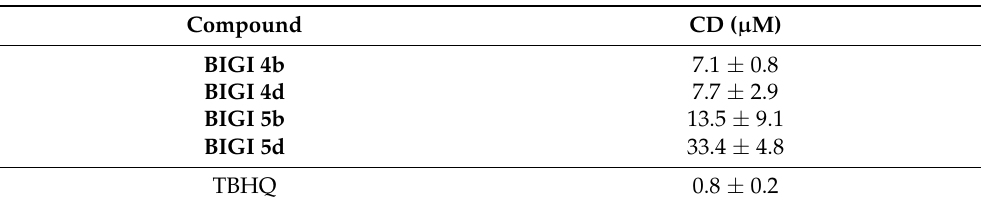
Data were plotted as concentration–response curves and fitted to a nonlinear equation. Data are expressed as the concentration required to double the specific luciferase reporter activity (CD) and are means ± SEM of at least 3 different experiments.